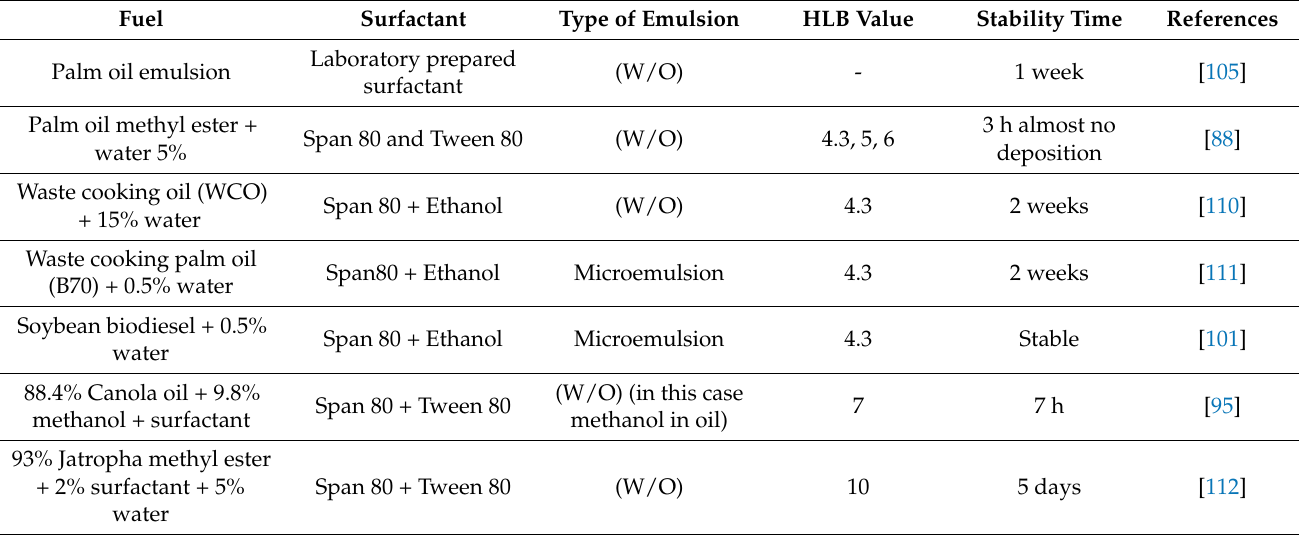
Table 5. The stability of various types of emulsified